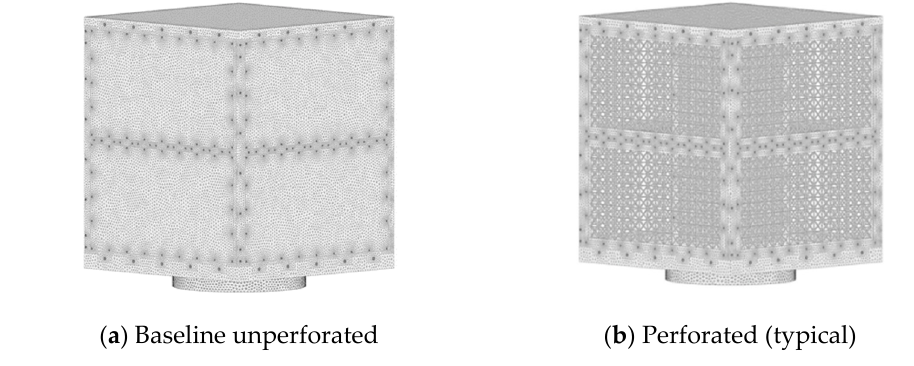
Figure 7. Converged finite element meshes.